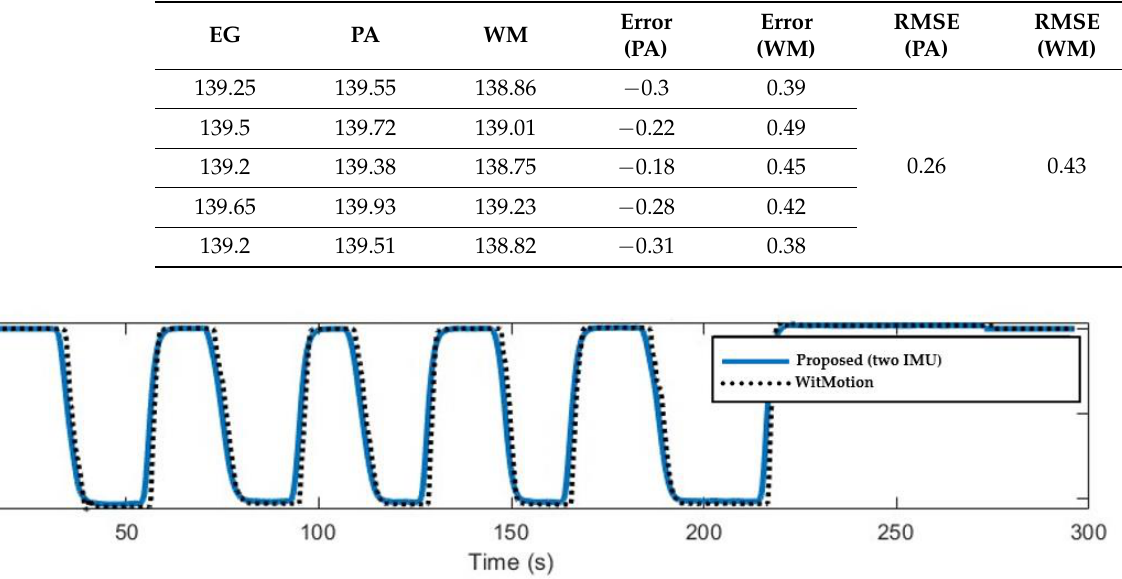
Figure 4. Measured angle from proposed algorithm (PA) and WitMotion (WM) using two IMUs. Table 3. Angle measurement comparison (RMSE in degrees) between the proposed algorithm (PA) and WitMotion (WM).